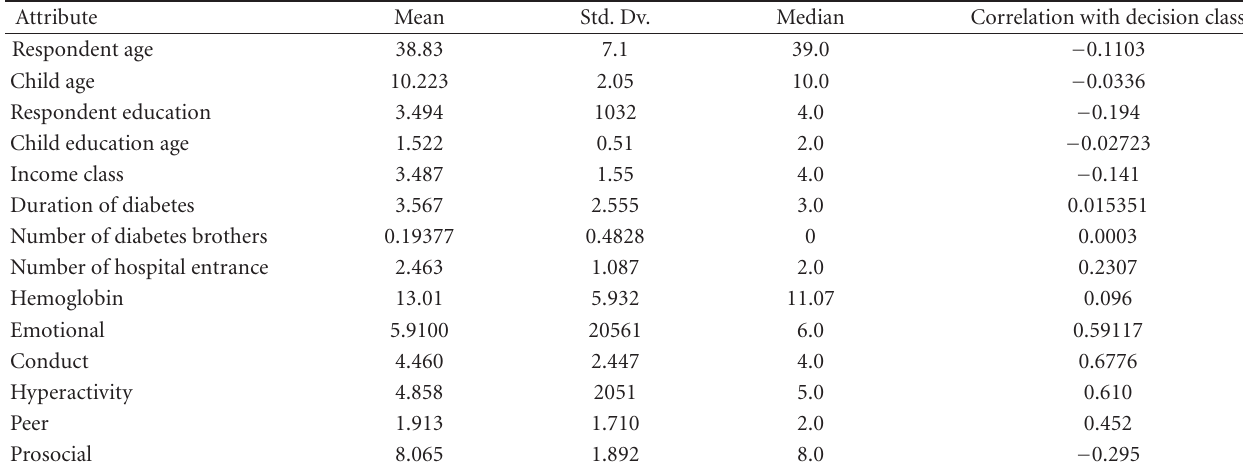
Table 3: Statistical results of the attributes.